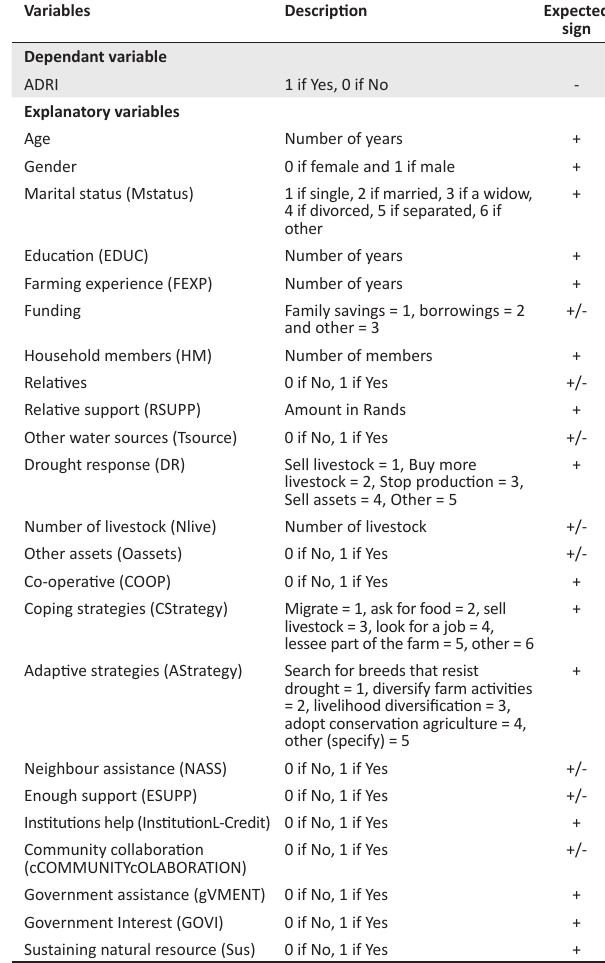
TABLE 3: Description of variables used in the probit model expected sign.